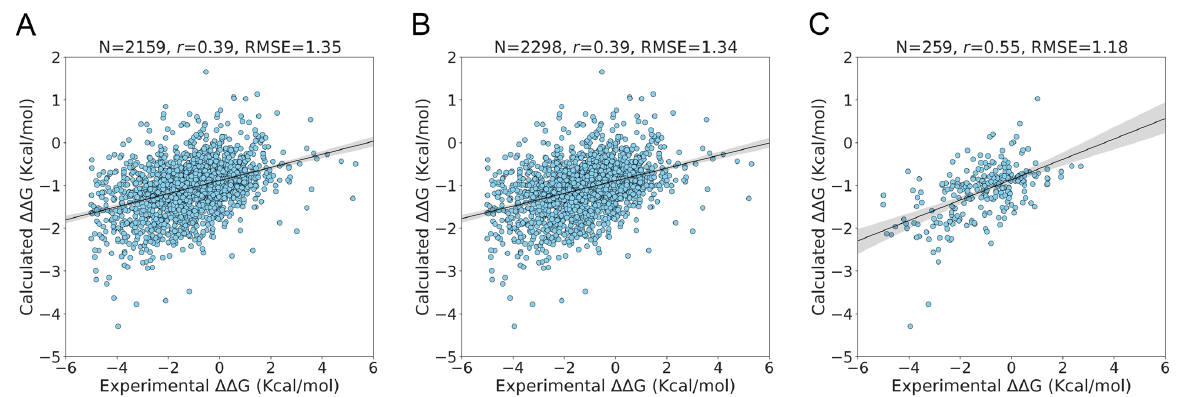
Figure 2. Performance on S2298 dataset. The extent of agreement between the experimental ∆∆ G and the PSP-GNM-calculated ∆∆ G is shown for ( A ) 2159 mutants having a PSP-GNM-calculated ∆∆ G, ( B ) all 2298 mutants, ( C ) 259 mutants with experimental temperatures ranging from 24 ◦ C to 26 ◦ C and pH ranging from 6.8 to 7.2. The regression line with the 95% confidence interval (shaded gray) is shown for all three cases. The optimal agreement is seen for ( C ), with a Pearson correlation of 0.55 and an RMSE of 1.18 Kcal/mol. We used a theoretical ∆∆ G value of 0 kcal/mol for cases without a PSP-GNM-calculated ∆∆